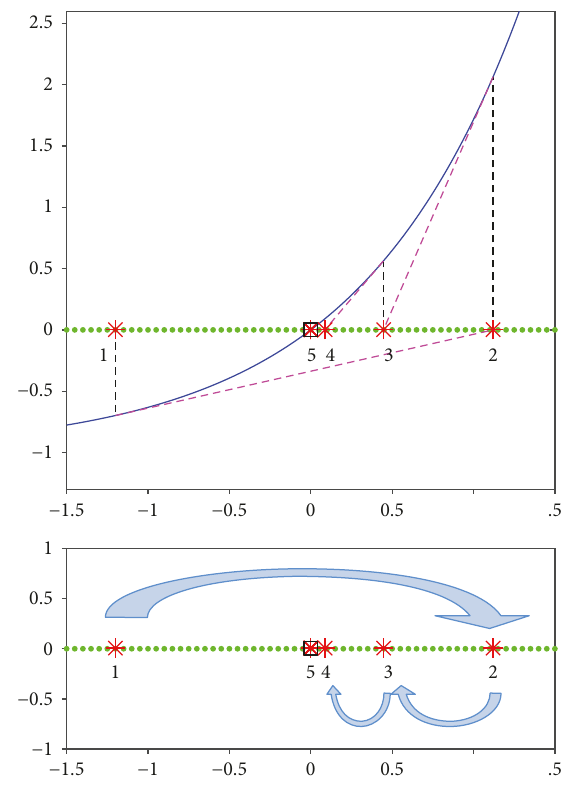
Figure 1: Illustration of the particle dynamics under a guiding function in the 1-dimensional search space: a particle is searching around a current optimum (boxed point) to fi nd a better one, moving from 1 to 5.